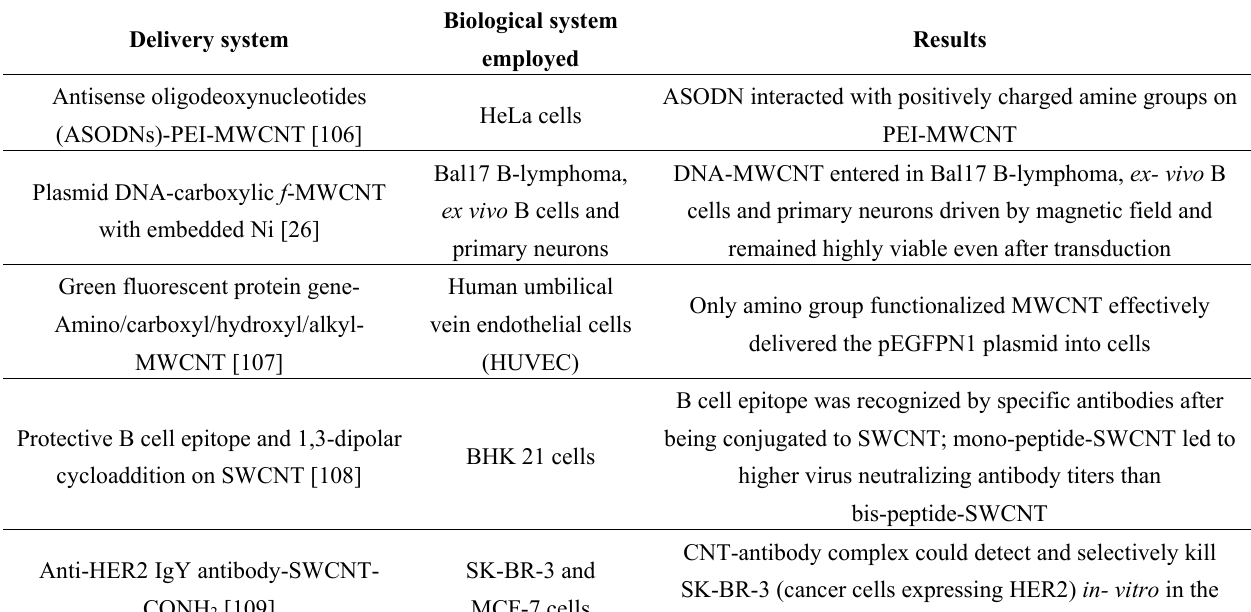
Table 3. Delivery of biomolecules through carbon nanotropes